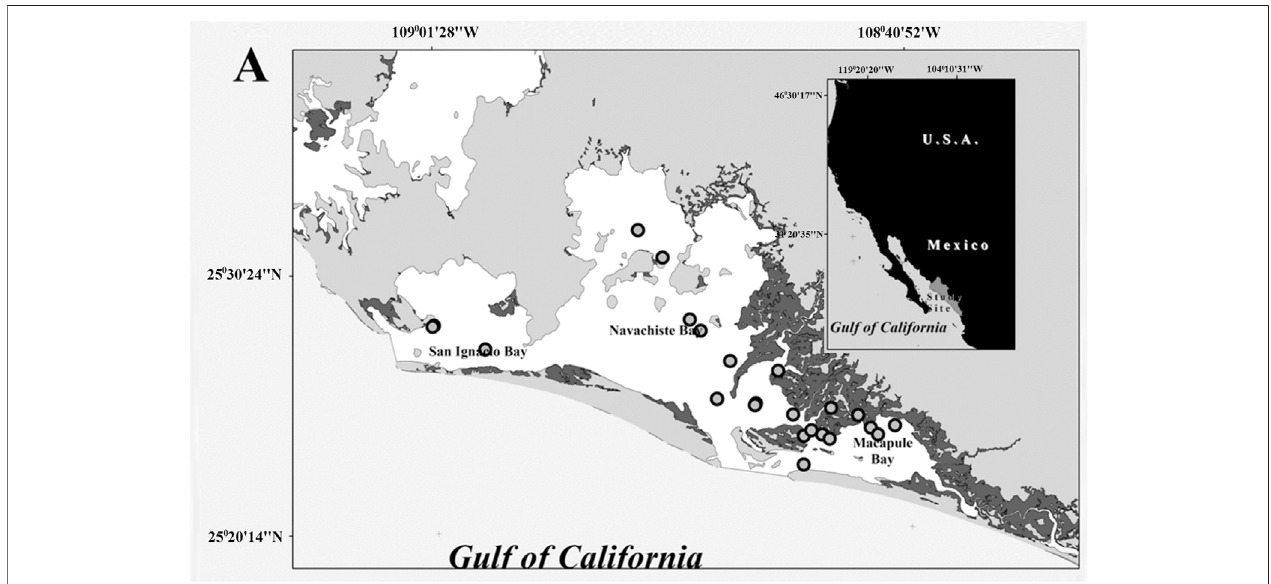
FIGURE 1 | NAV lagoon complex location and C. bellicosus sampling